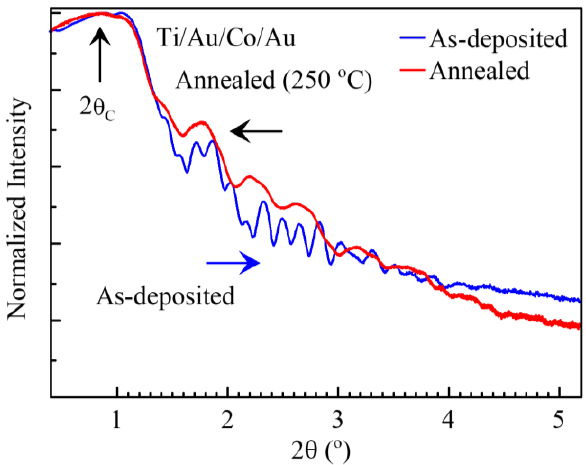
Figure 2. Comparison of X-ray reflection profiles of as-deposited (denoted by blue) and annealed (denoted by red). The blue horizontal arrow shows the direction of increasing roughness. The vertical black arrow shows the position of the critical angle (2 θ c )—the angle above which total internal reflection takes place.